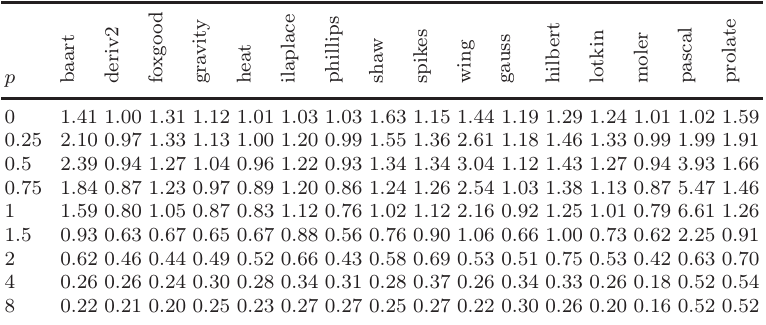
Table 8. Means (over all p ) of error ratios and errors for problem heat.